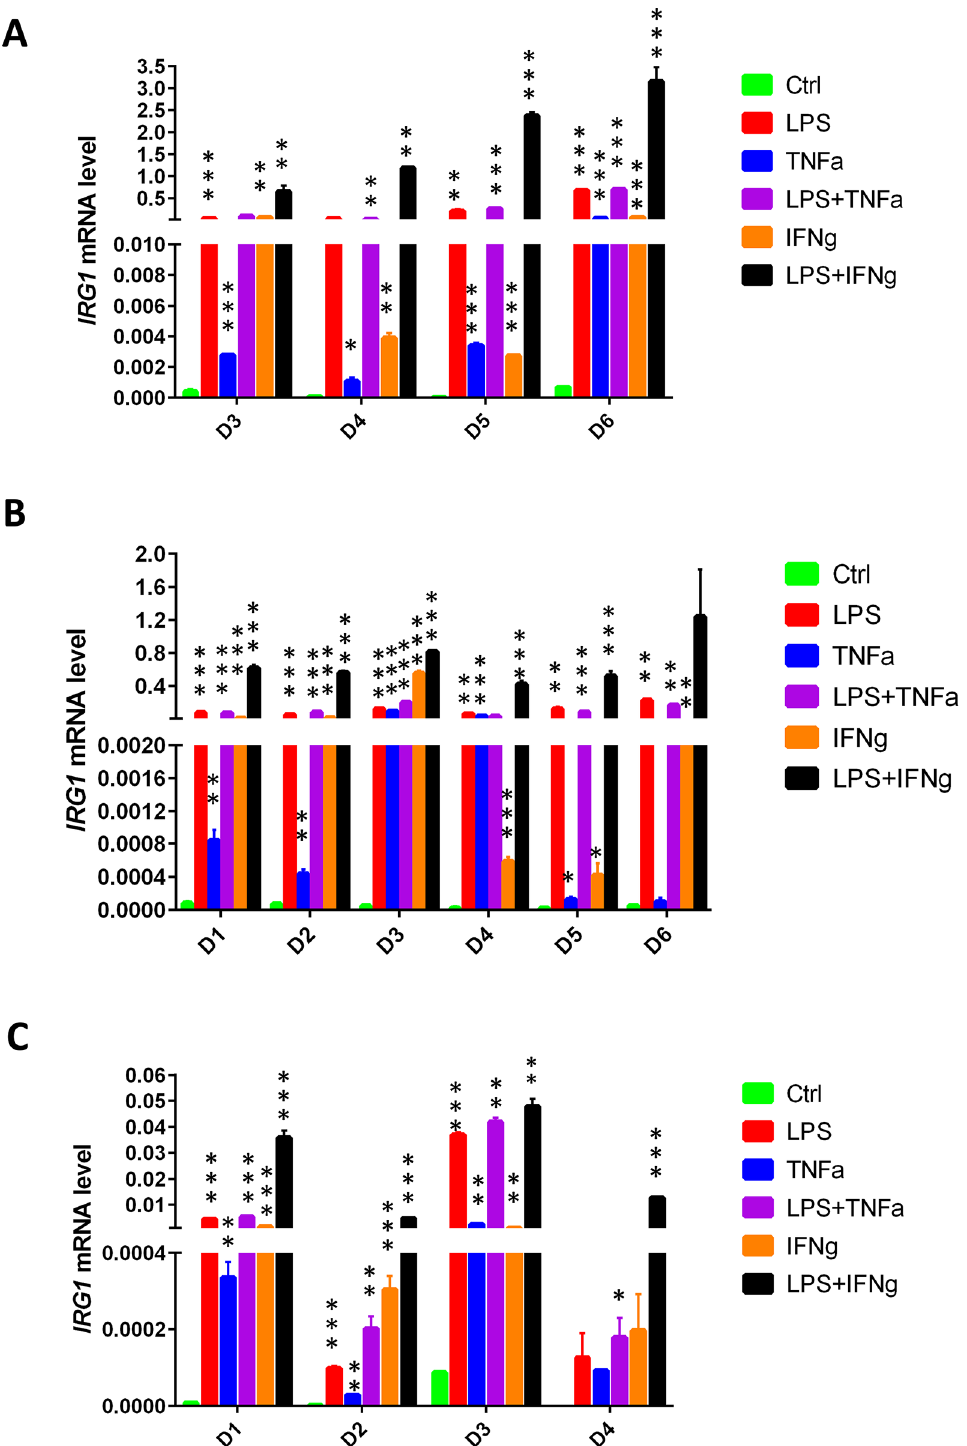
Fig 2. IRG1 expression in human immune cells under pro-inflammatory conditions. RNA was extracted from ( A ) PBMCs-derived monocytes, ( B ) PBMCs-derived macrophages and ( C ) PBMCs-derived dendritic cells 6 hours after treatment with LPS (10 μ g/ml), TNF α (50ng/ml), IFN γ (10ng/ml) and LPS together with TNF α or IFN γ in independent donors (D1-D6). The bars show the mean of 3 technical replicates ( ± SEM) of IRG1 mRNA levels measured by real-time PCR normalised with L27 as the housekeeping gene. *** p < 0.001, ** p < 0.01, * p < 0.05.